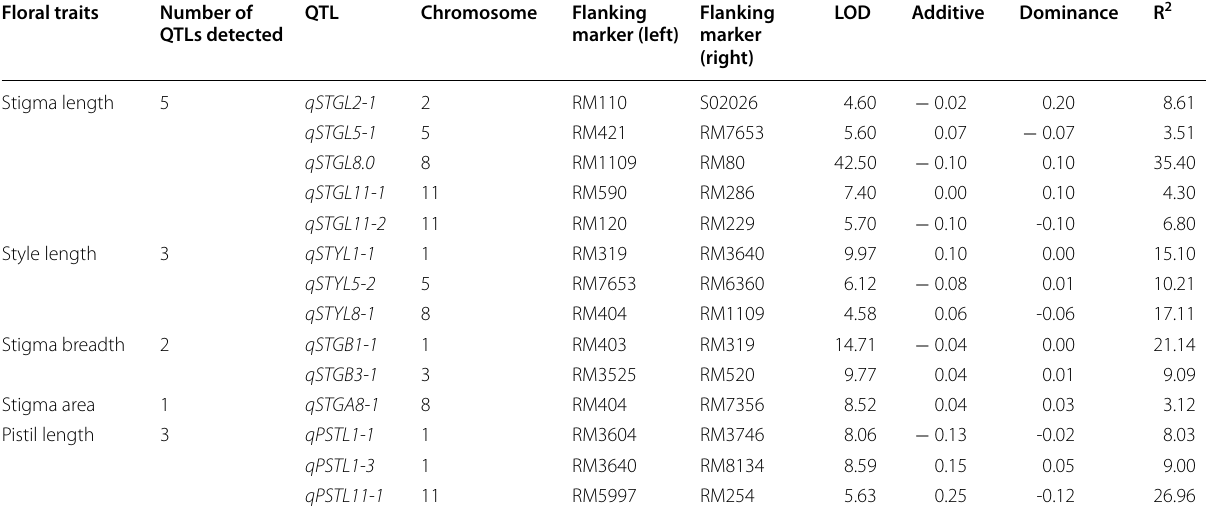
Table 2 List of floral trait QTLs detected in IR64 confidence and 1000 permutations